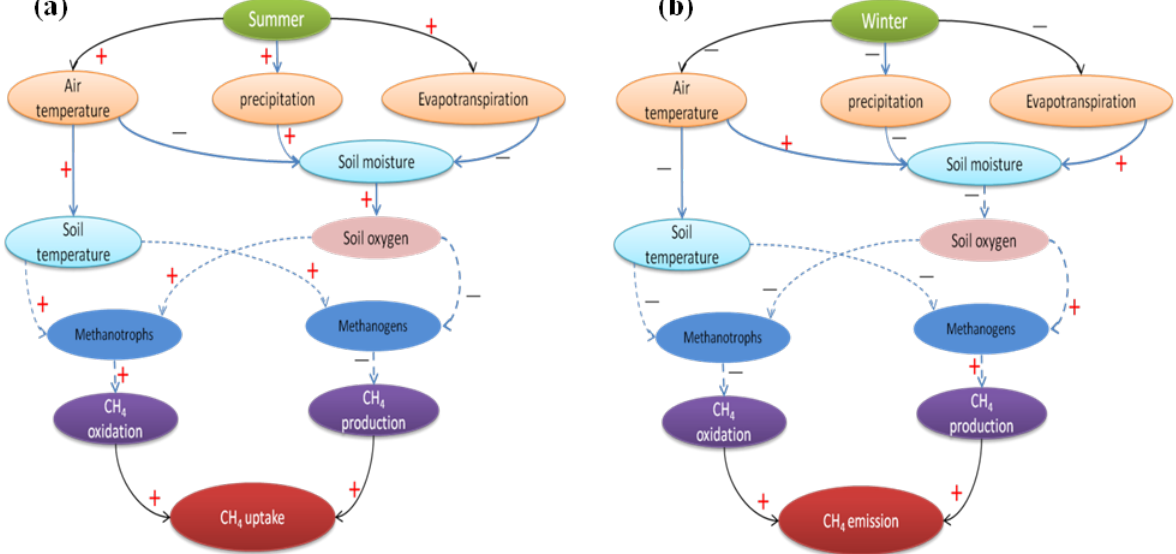
Figure 7. Mechanisms of methane uptake and emissions between summer ( a ) and winter ( b ). “+”, positive contribution or stimulation; ‘‘−’’ , negative contribution or suppression. Since no measurement was made, the dotted line represents the possible effects.